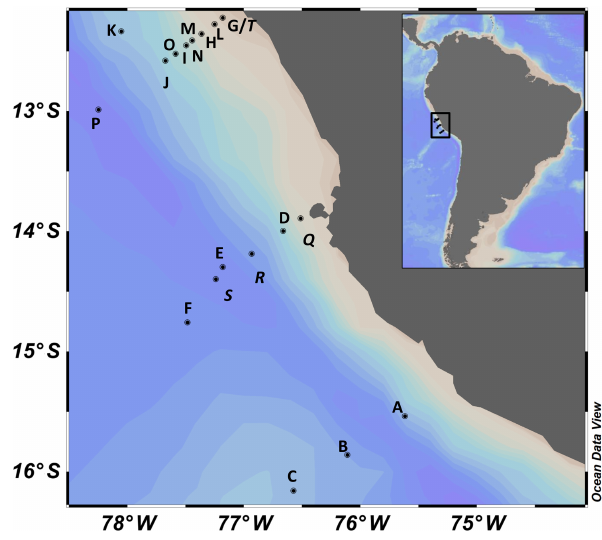
Figure 1. Station map. All presented stations in the eastern tropical South Pacific off Peru sampled in 2017. For detailed information about the stations, see Table